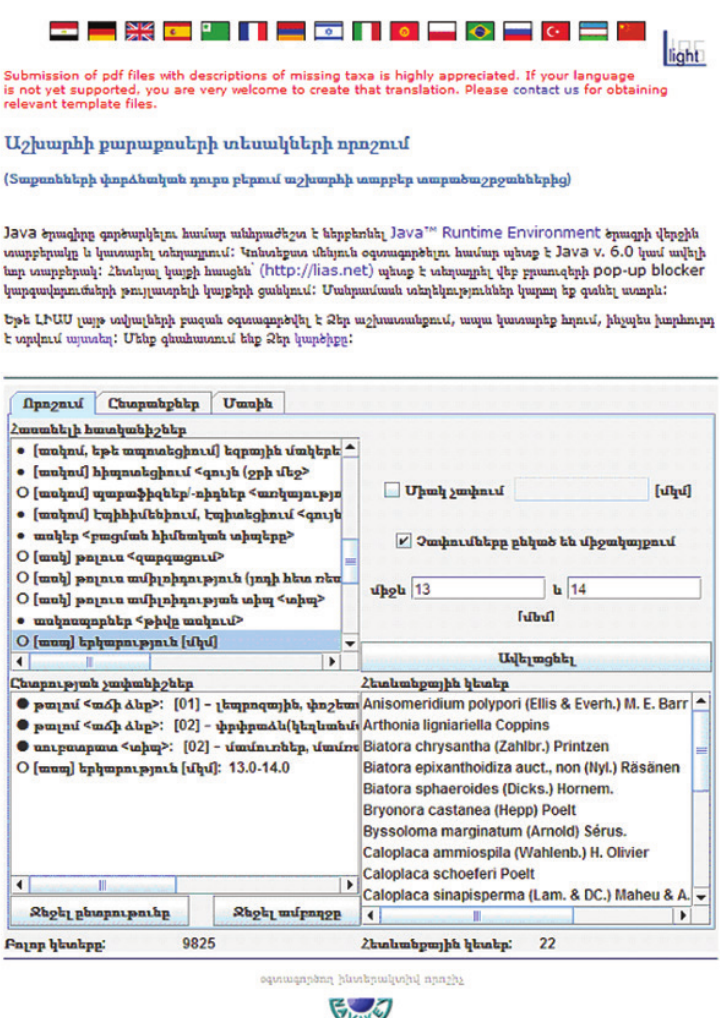
Figure 1. LIAS light web interface NaviKey in Armenian